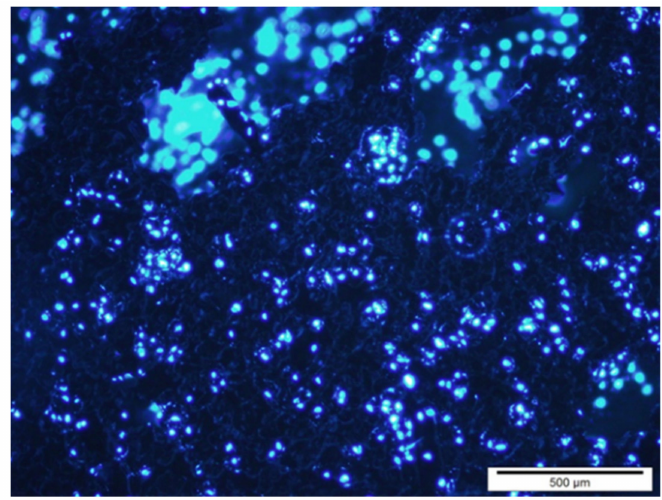
Figure 15. Human osteoblasts on the porous titanium surface at seven days.